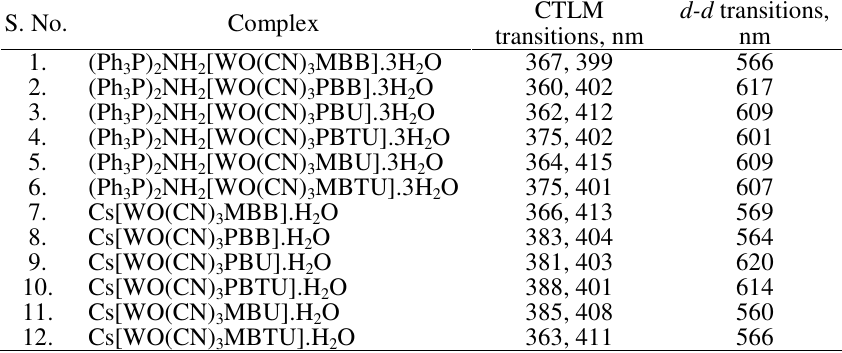
Table 3. Electronic spectra of the oxotungsten(IV)